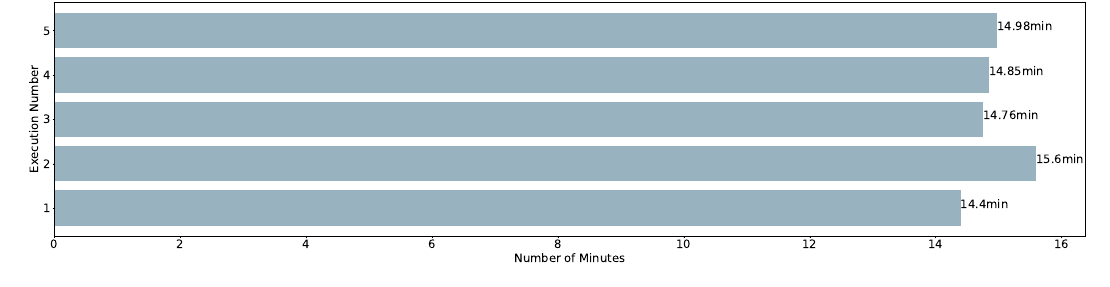
Figure 13. Time spent to execute Pangea over different